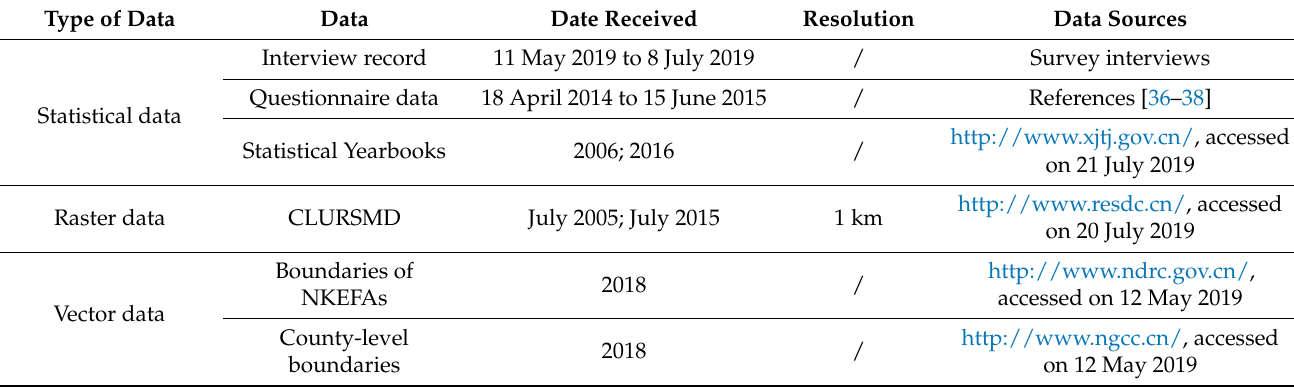
Table 1. Summary of dataset